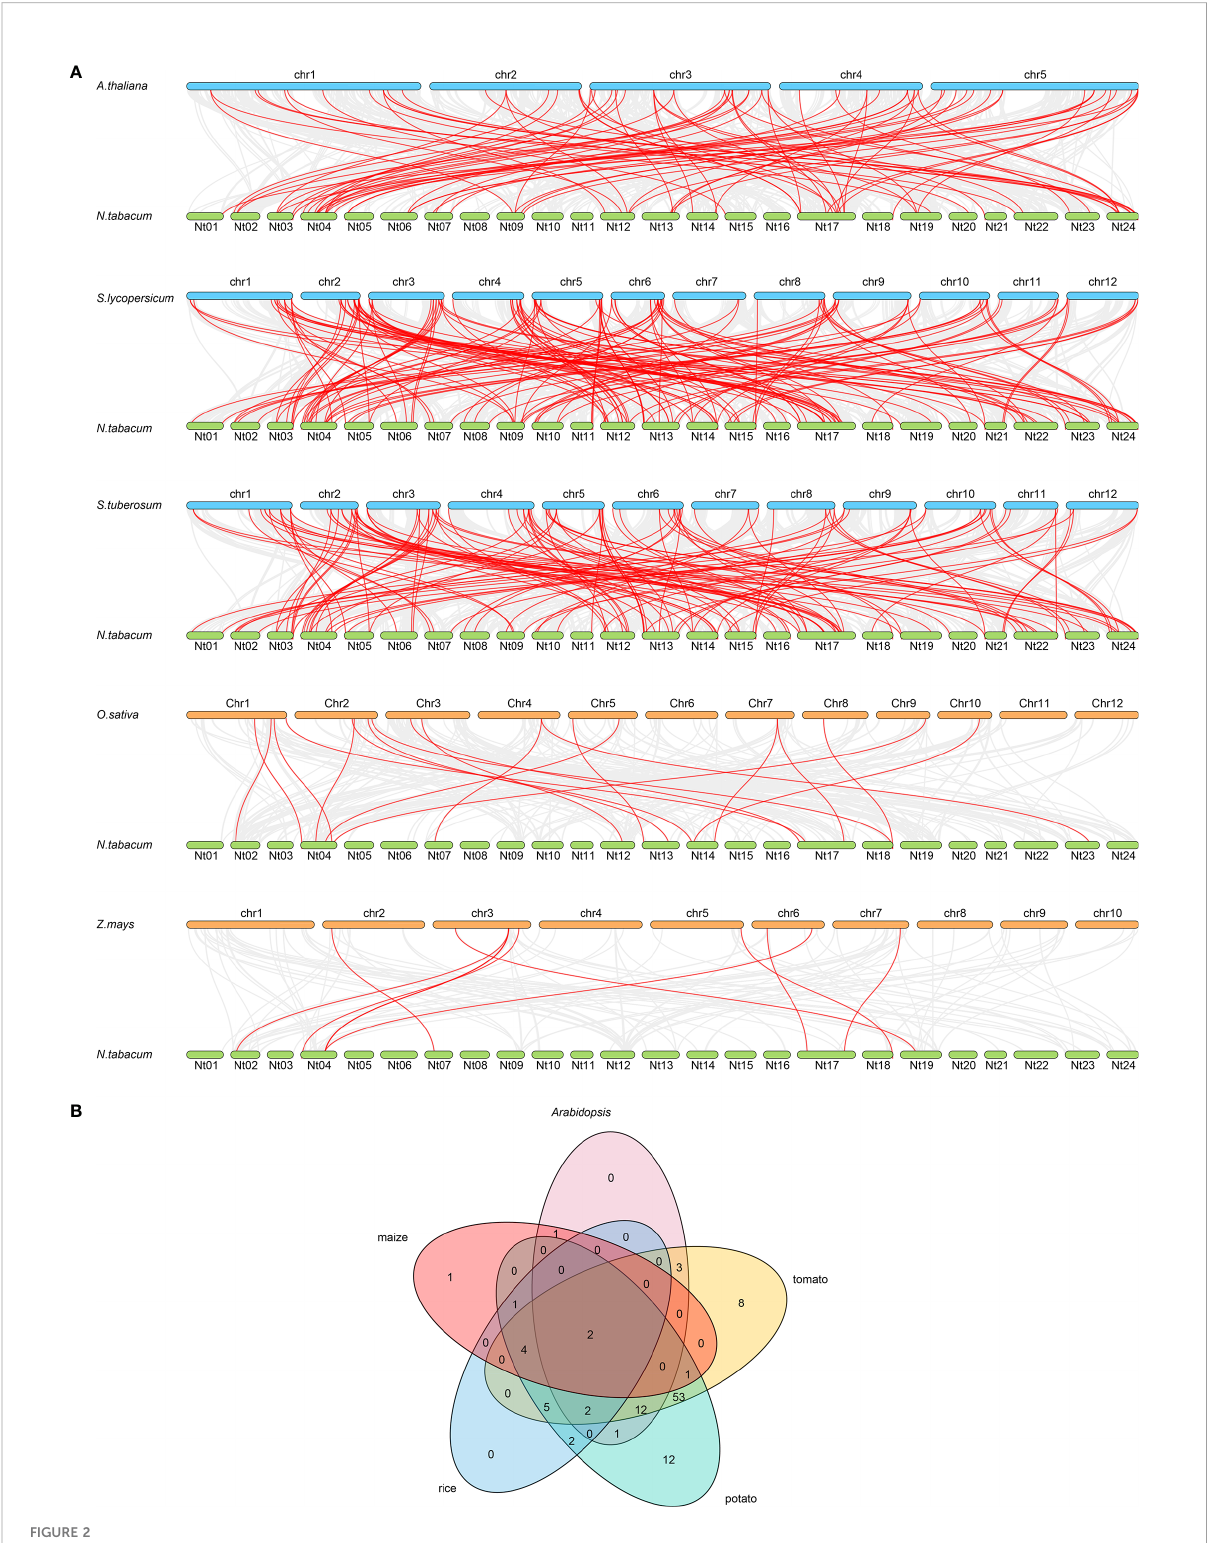
FIGURE 2 The synteny analysis of R2R3-MYB genes between tobacco and fi ve representative species. (A) The gray line in the background represents the collinear blocks between tobacco and fi ve representative species, while the collinear R2R3-MYB gene pairs are highlighted in red color. (B) The R2R3-MYB genes form the syntenic pairs between tobacco and all the other selected species, which is visualized by the Venn